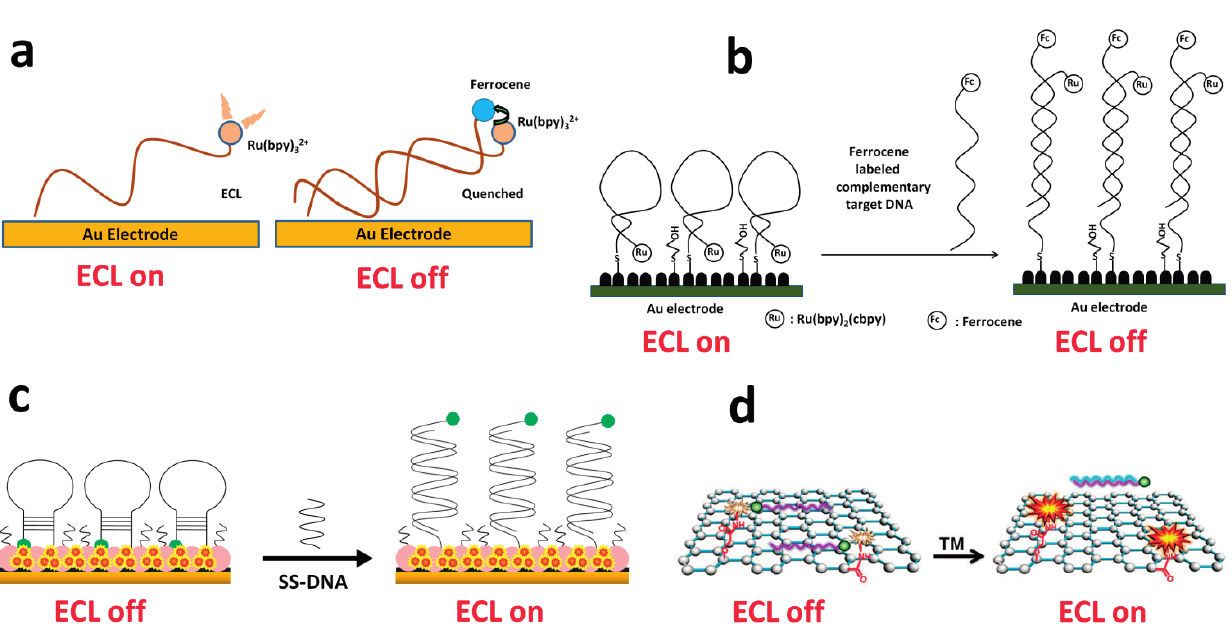
Figure 13. ECL DNA detection based on quenching the ECL of Ru(bpy) 32+ by